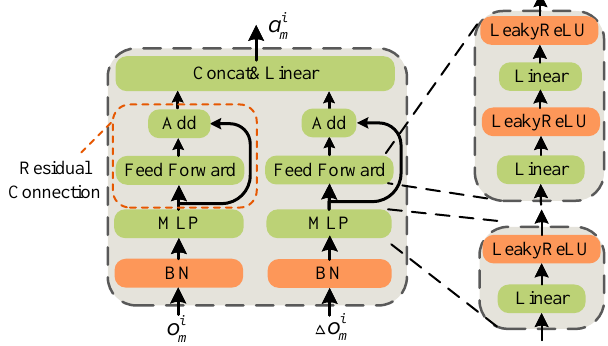
Figure 4. The structure of Double-Stream Actor